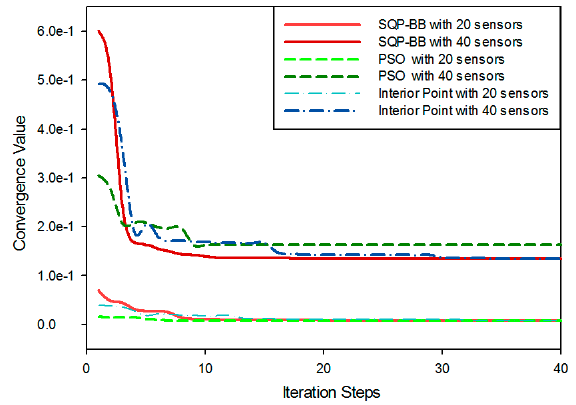
Figure 13. Convergence comparison between the proposed and other algorithms.